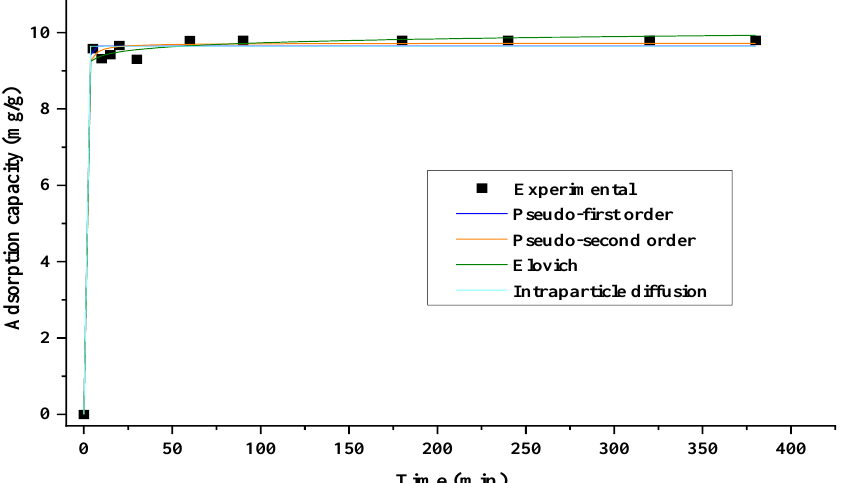
Figure 7. Non-linear adjustment of the adsorption kinetics of Cr (VI) at pH 2, 55 °C, 200 mg L −1 and 0.14 g of adsorbent.